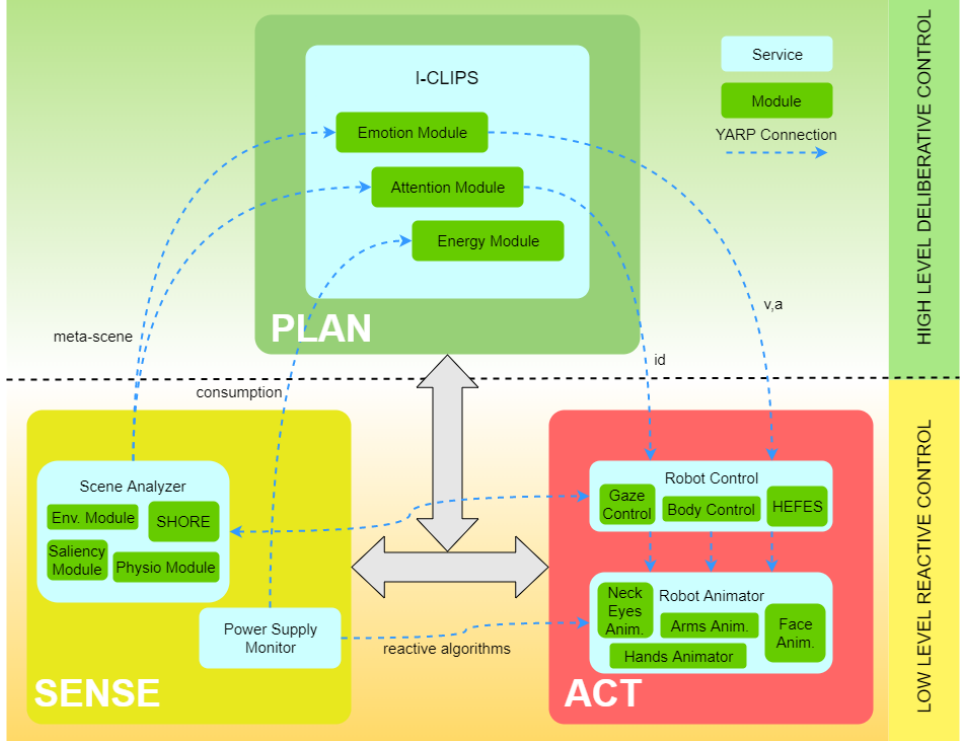
Figure 6. A functional framework of the SEAI cognitive architecture (Social Emotional Artificial Intelligence). Image taken from [77]. More details on single services reported in the figure can be found in